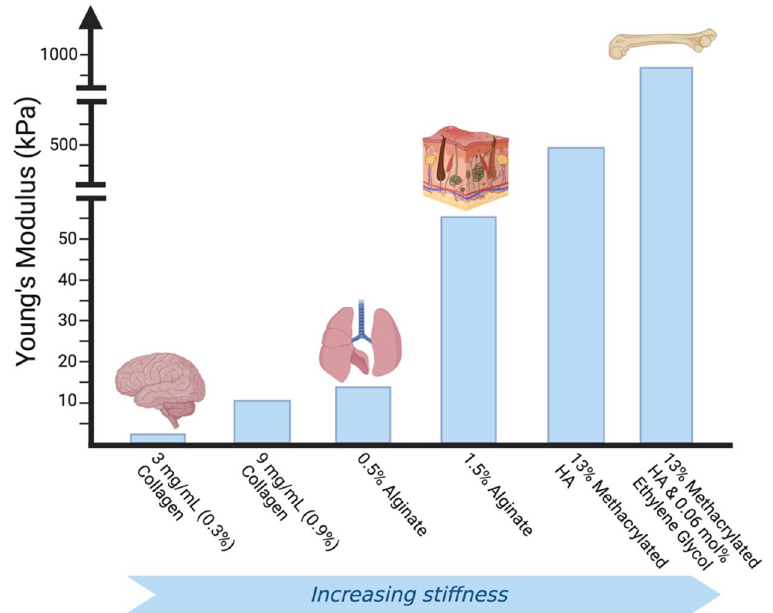
Figure 3. Young’s modulus of hydrogels. The reported Young’s modulus (kPa) values of various hydrogels are plotted with an image of the tissue that has similar Young’s modulus. It is crucial to choose a hydrogel model that corresponds to the in vivo mechanical properties of tissue that is relevant to the work. (Created with BioRender.com, accessed on 14 July 2022) .